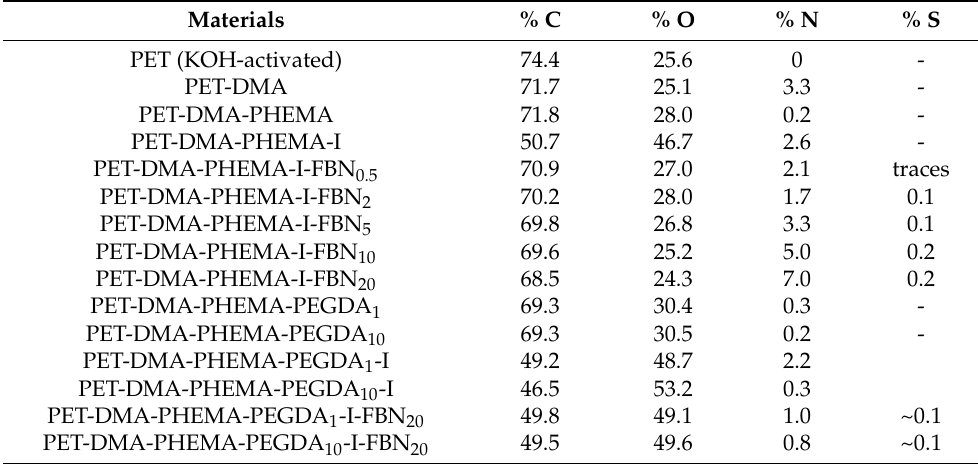
Table 1. Surface chemical composition (in at. %) of bare and modified PET